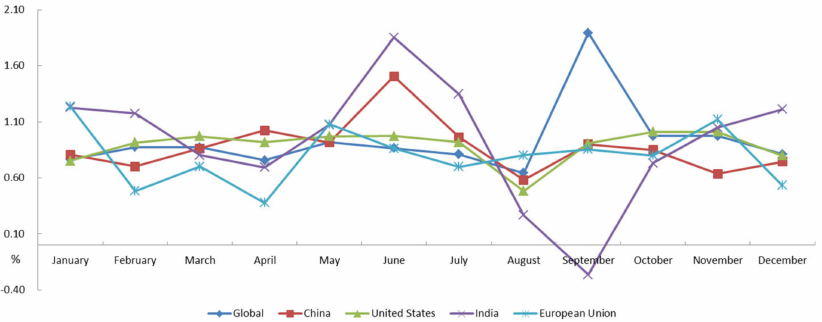
Figure 8. Monthly changes in CH 4 concentrations for global land and major countries/regions in